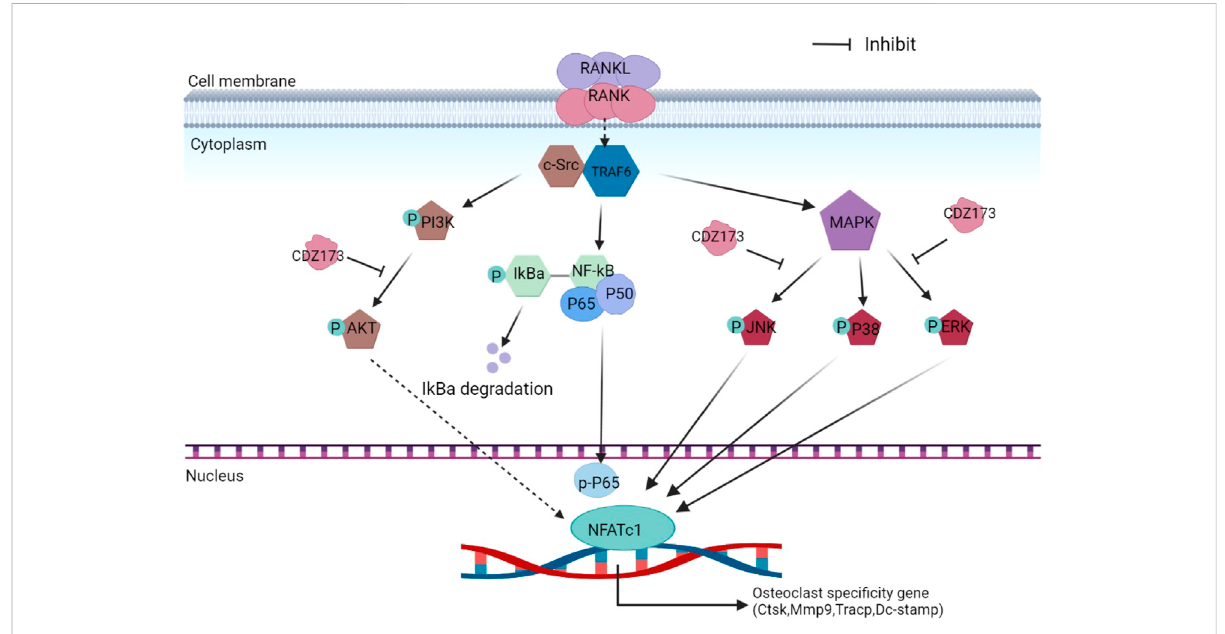
Schematic diagram of the suppressing in fl uence of CDZ173 on the formation of